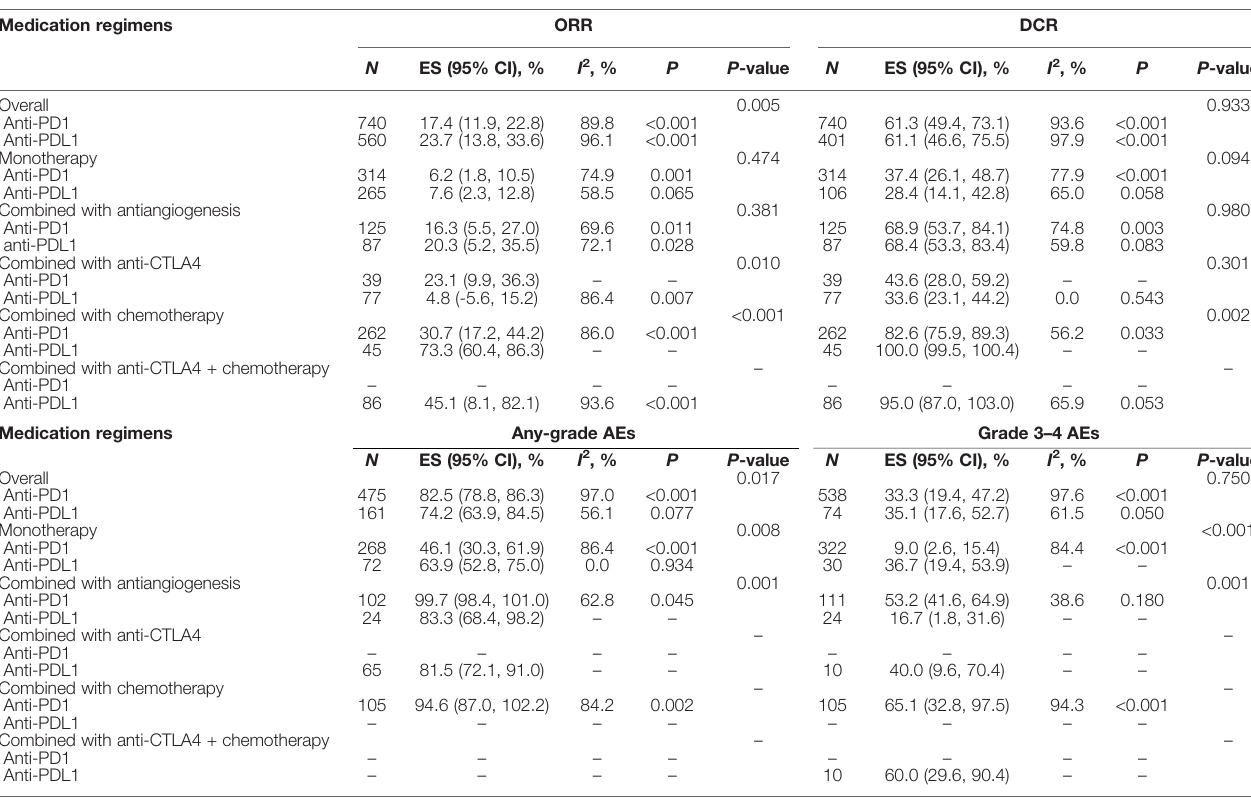
TABLE 4 | Pooled results of ORR, DCR, any-grade AEs, and grade 3 – 4 AEs of anti-PD1-containing regimens or anti-PDL1-containing regimens in aBTC. Medication